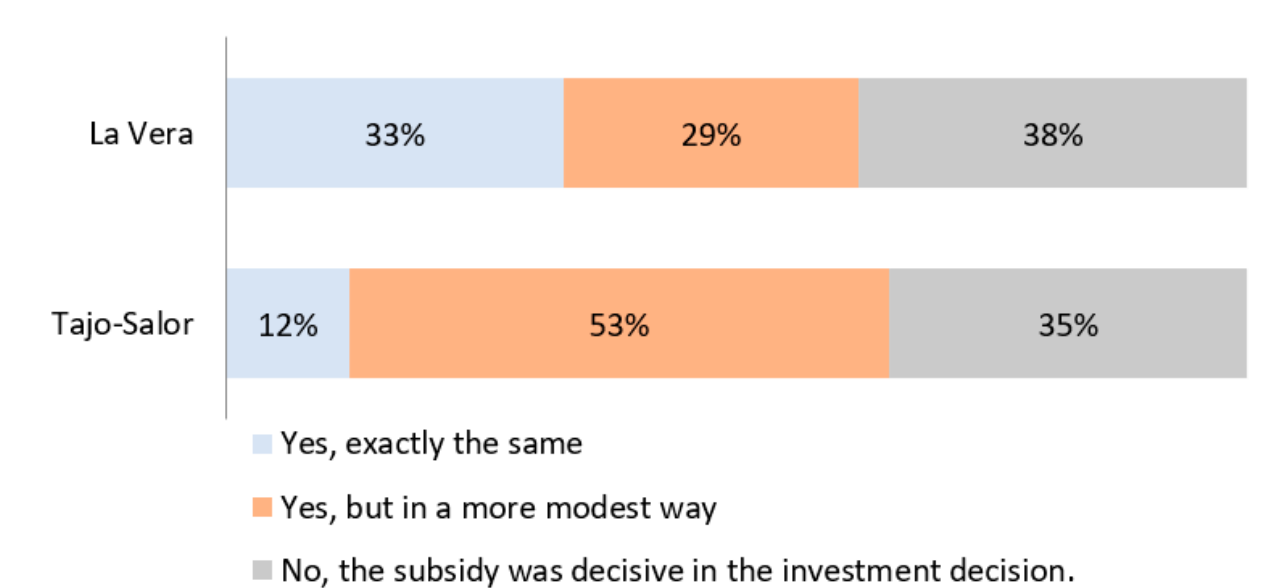
Figure 4. Would you have undertaken the investment without the grant received? Source: Own